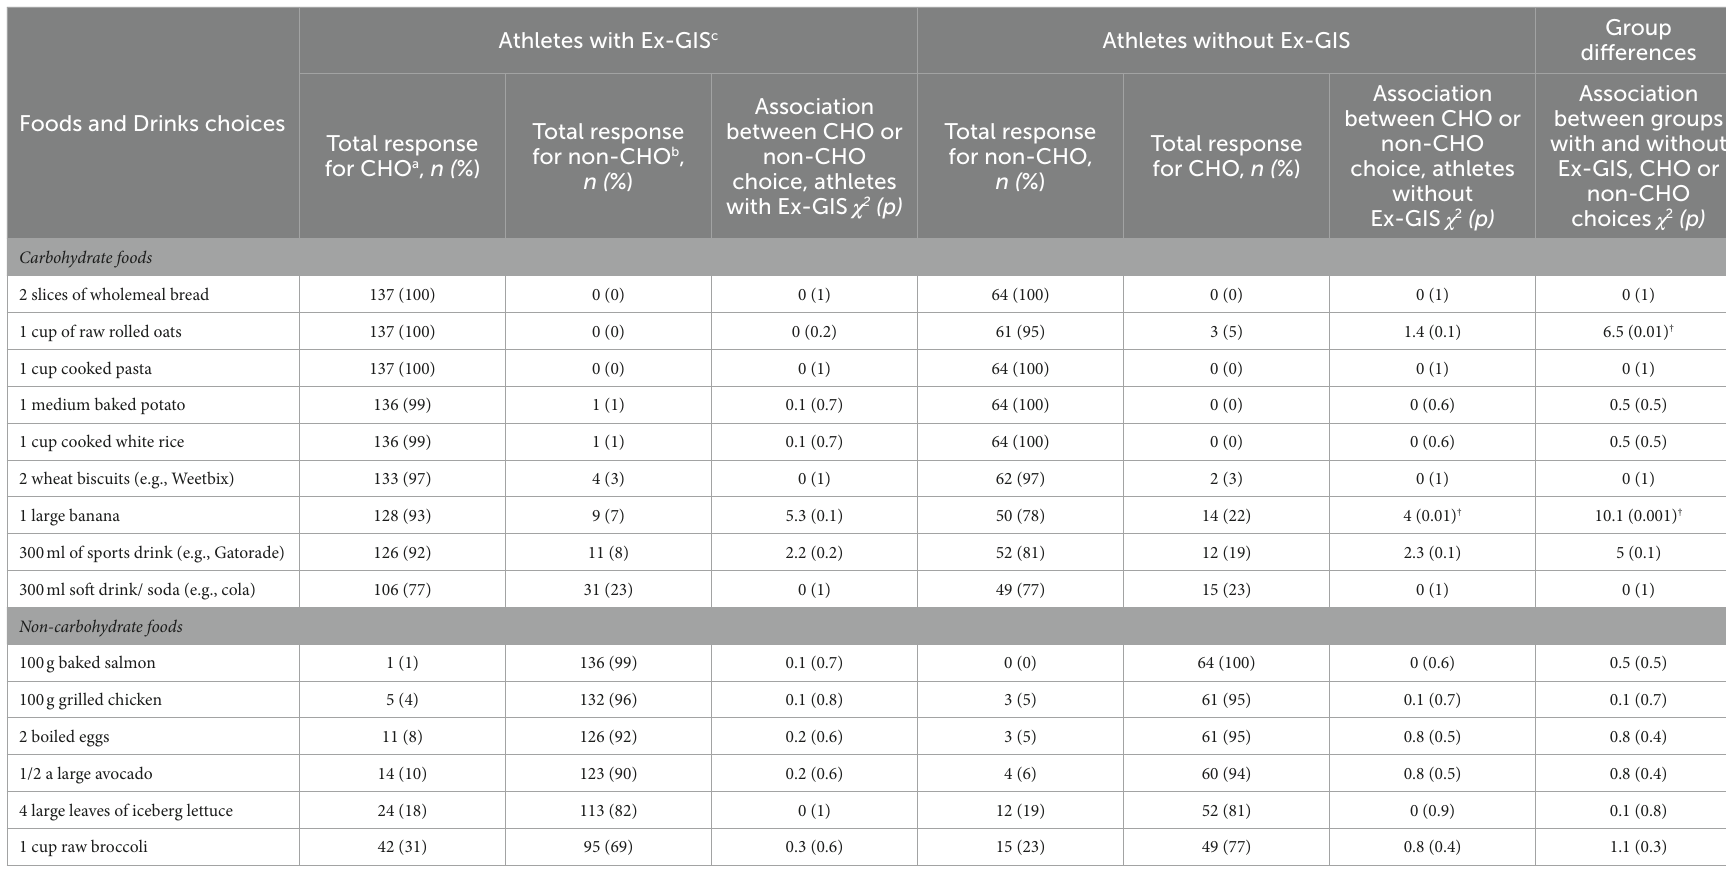
TABLE 3 Carbohydrate knowledge comparisons between endurance athletes with ( n = 137) and without ( n = 64) reported exercise-associated gastrointestinal symptoms for 15 food and drink items classified as either carbohydrate or non-carbohydrate choices analyzed with Chi-squared comparison and post-hoc Bonferroni adjustment.